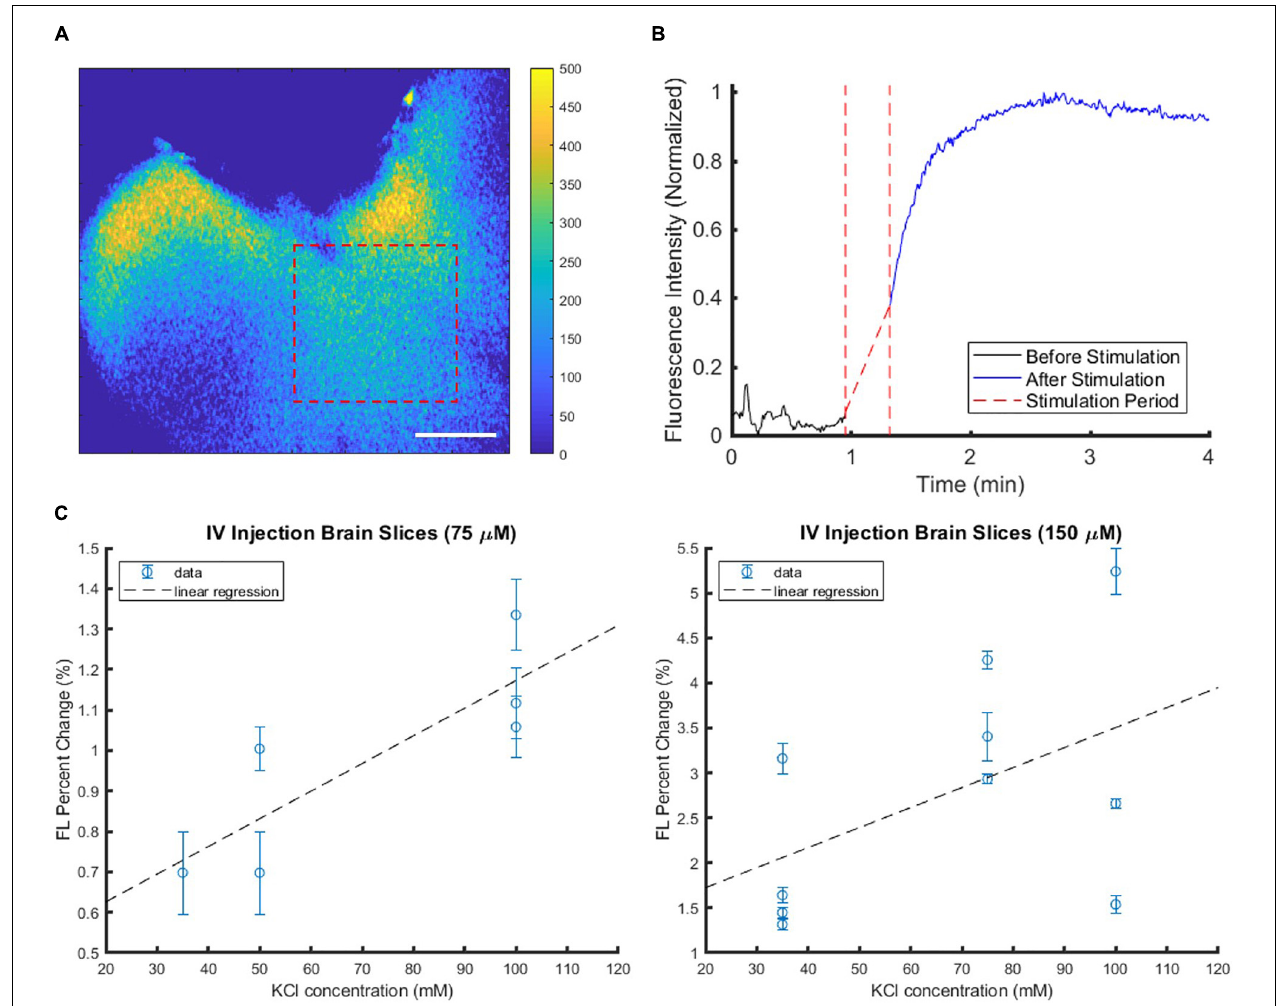
FIGURE 4 | Sample brain slice with IV injected VSD in the well plate setup with KCl applied as a stimulant at the 1-min mark. (A) The subtraction colormap (image before stimulation subtracted from that after stimulation at 4 min) visualizes the stimulation-evoked changes that are also plotted in (B) which shows the increased fluorescence signal level post-stimulation. Scale bar = 2.5 mm. (C) Brain slice fluorescence responses were compiled at various KCl stimulation levels with VSD injection concentrations of 75 µ M (left) or 150 µ M (right) delivered intravenously. Each plot represents data collected from multiple slices from the same IV VSD-injected mouse and treated with different KCl concentrations. Each data point represents the mean fluorescence (FL) change of one slice, and the error bar indicates the variability within that slice, namely, how response strengths varied over different tissue ROIs within the